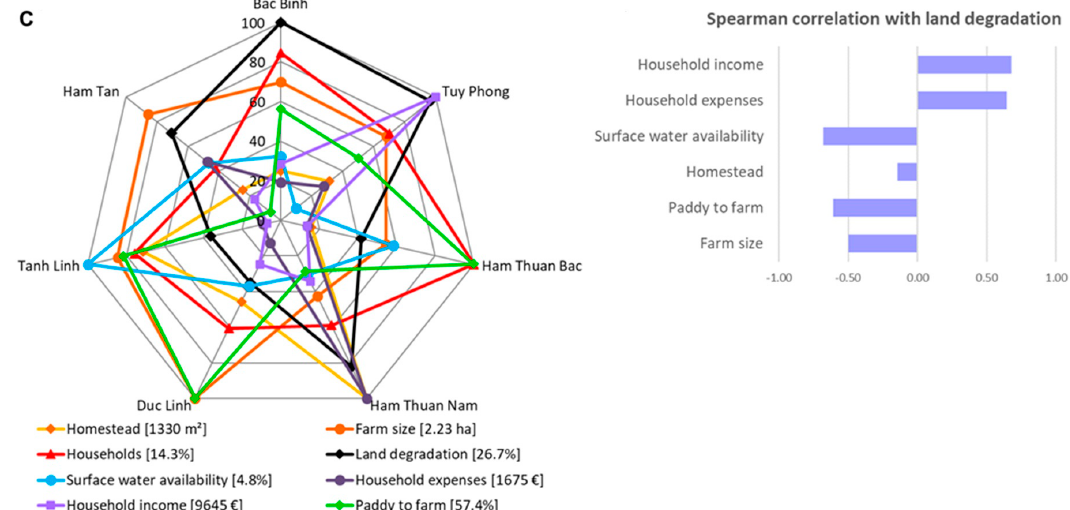
Figure 8. Vulnerability indicators and Spearman correlation with land degradation. ( A ): at the district level, ( B ): at the community level where C refers to coastal area, L to lowland plains and M to hills and mountains, and ( C ): at the household level, aggregated to district name. Values are scaled as percentages of the maximum value, as given between brackets. See Figure 2 for the locations of districts.